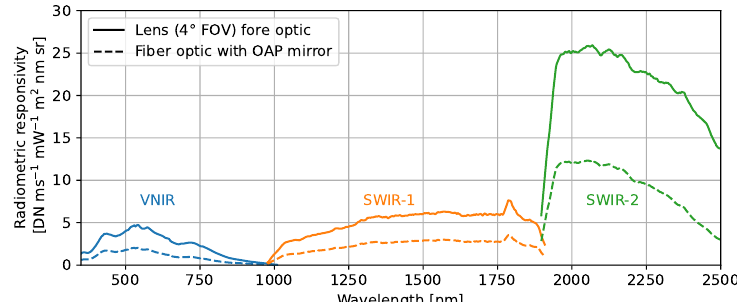
Figure 7. Radiometric responsivity of the spectroradiometer from calibrations with either a 4° FOV lens or the fiber bundle with an off-axis parabolic (OAP) mirror as applied in the radiance transfer